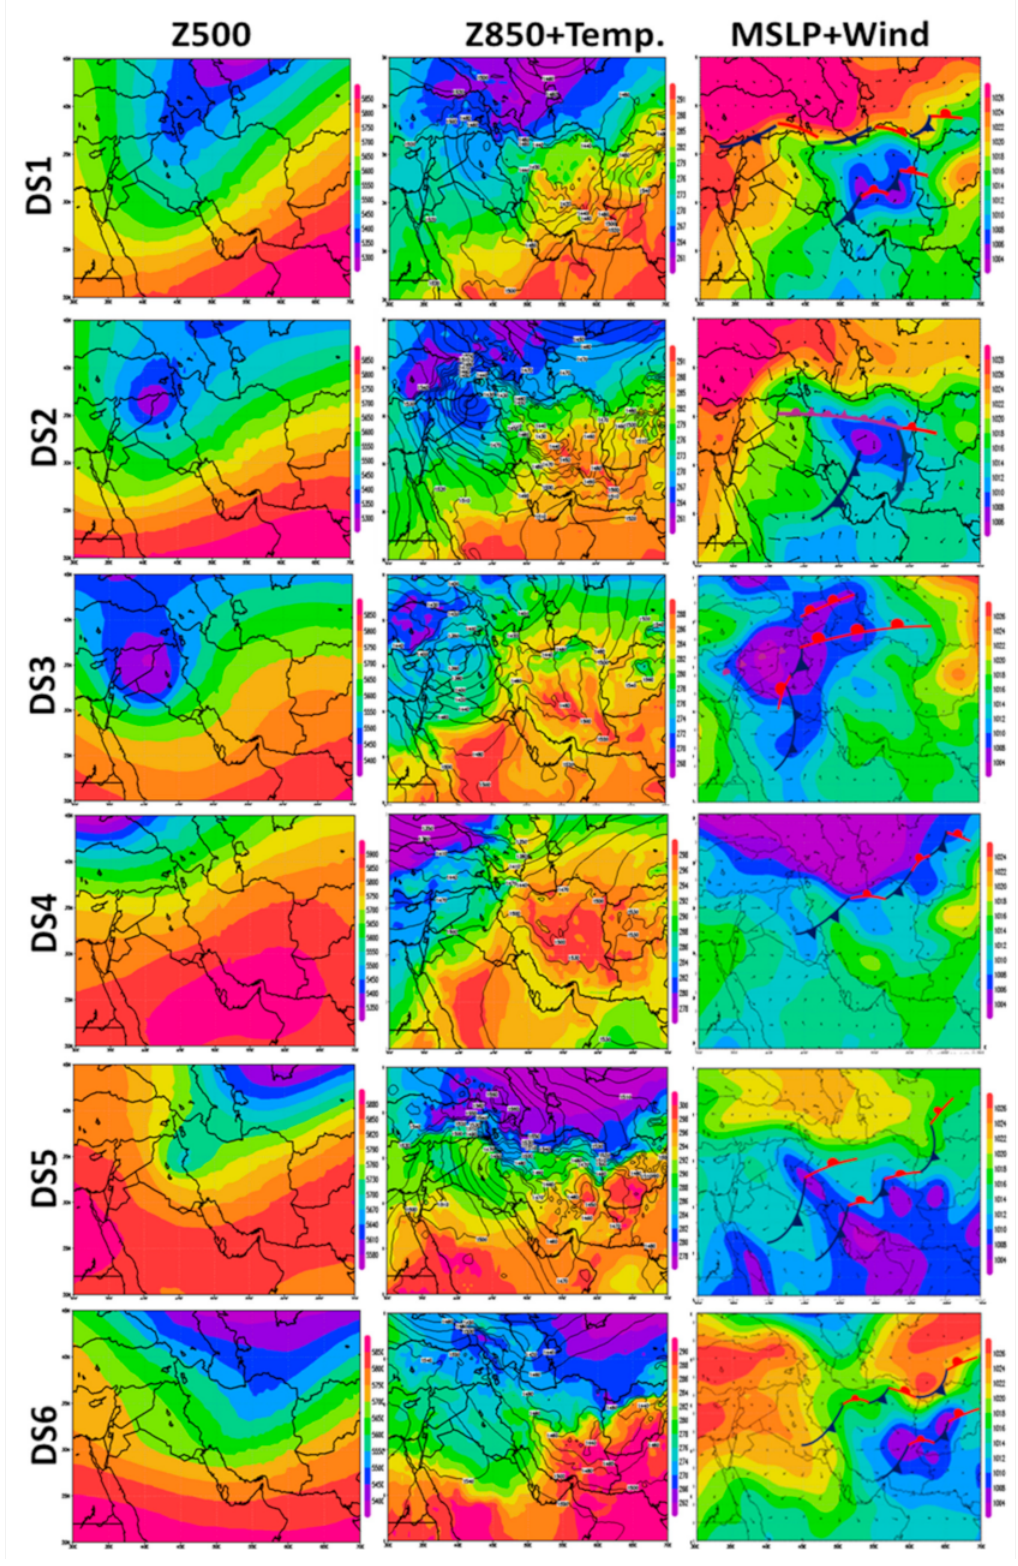
Figure 2. Synoptic maps of the geopotential heights (m) at 500 hPa, 850 hPa along with temperature (K), and mean sea level pressure (hPa) along with winds and surface fronts taken from Global Forecast System (GFS) analysis at 12:00 UTC